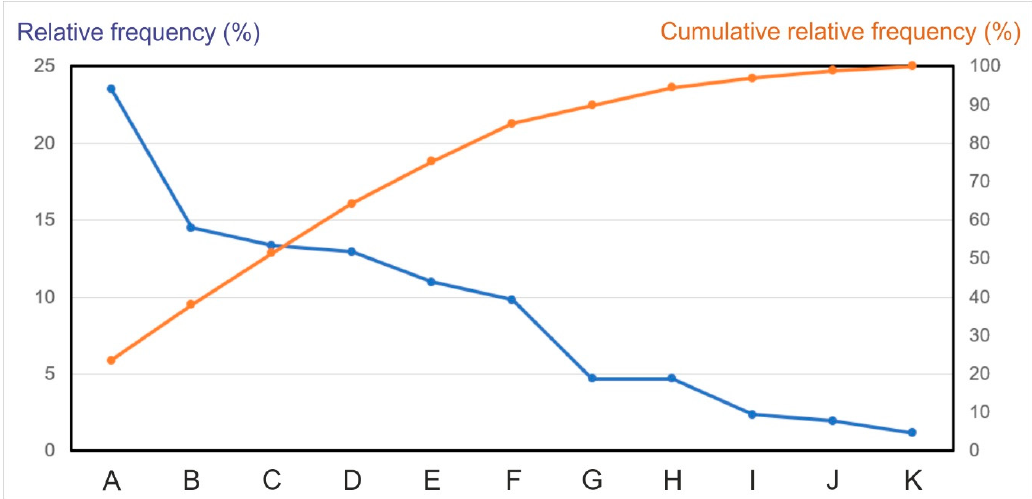
Figure 2. Relative frequency and cumulative relative frequency of PS ‐ OSs characteristics described in papers of our paper database—results of the first assignment process (paper groups are marked with the same letters as the paper groups listed above, see Table 1.).